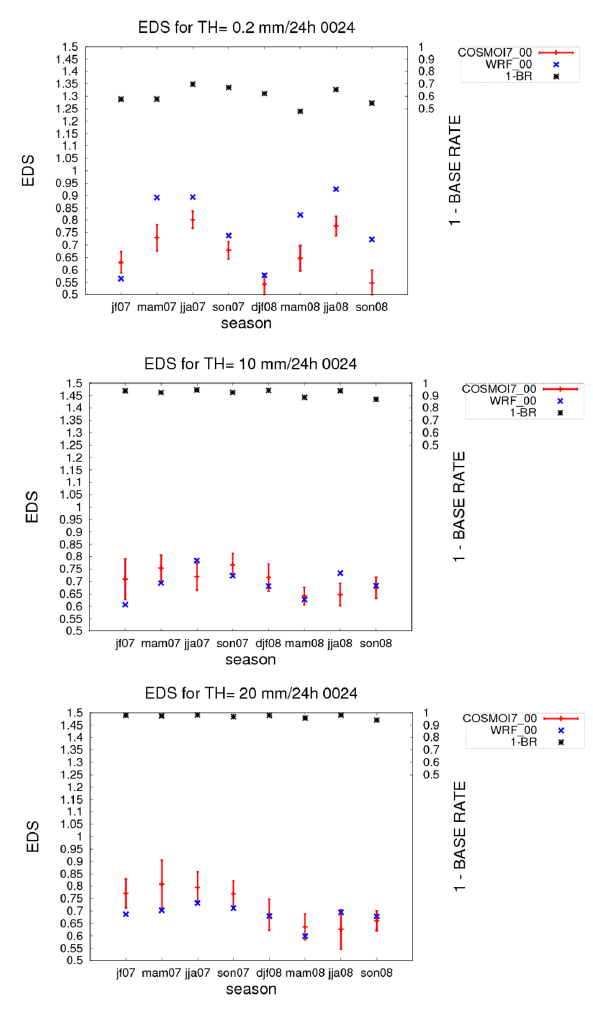
Fig. 9. Seasonal trend: EDS vs. increasing threshold (0.2mm24h − 1 , 10mm24h − 1 , 20mm24h − 1 ) for the first day of forecast. The dashe red lines and the blue daggers represent COSMO-I7 and WRF respectively. The Base Rate (stars) is plot- ted for each